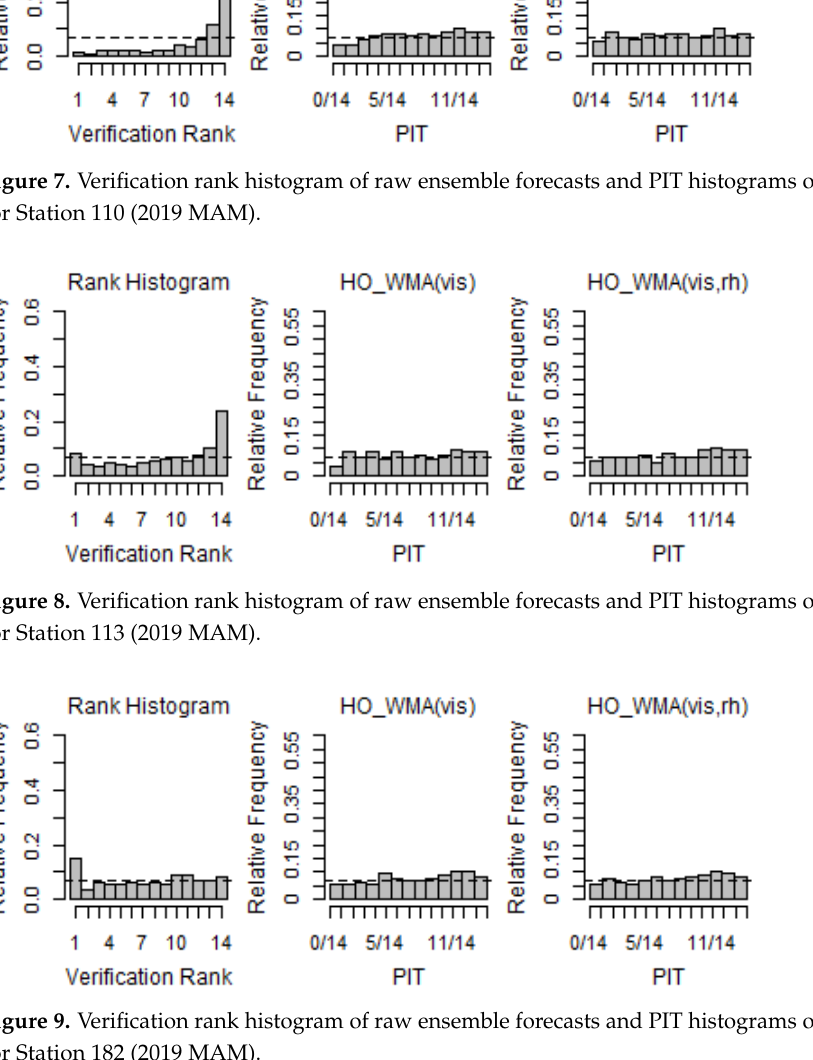
Figure 9. Verification rank histogram of raw ensemble forecasts and PIT histograms of WMA models for Station 182 (2019 MAM).